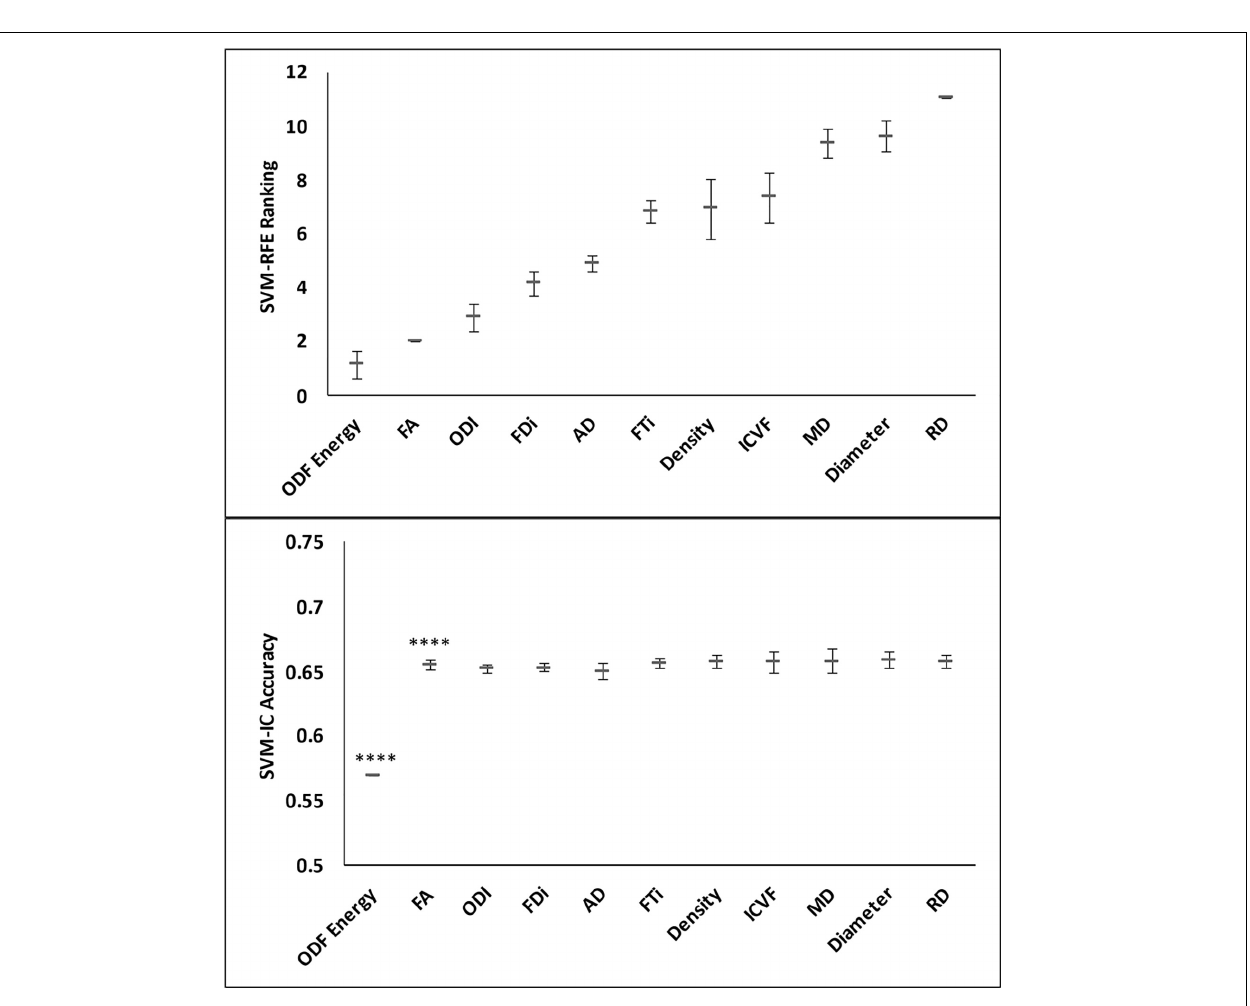
Frontiers in Neuroscience |